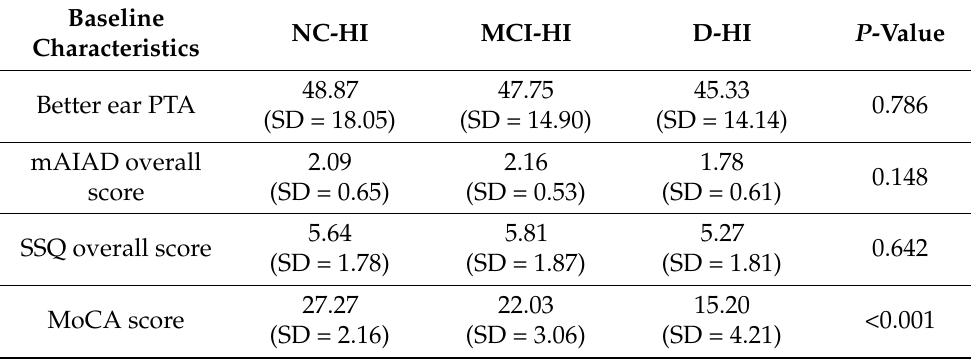
Table 1. The baseline characteristics of the NC-HI, MCI-HI and D-HI groups.